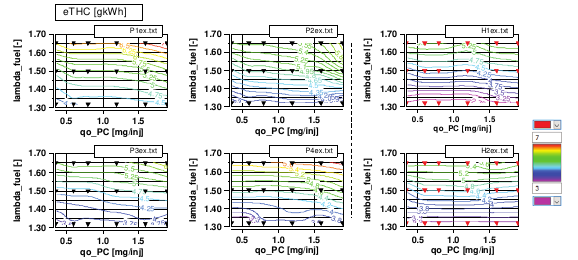
Fig. 17. The THC emission maps obtained for P- and H-type prechambers